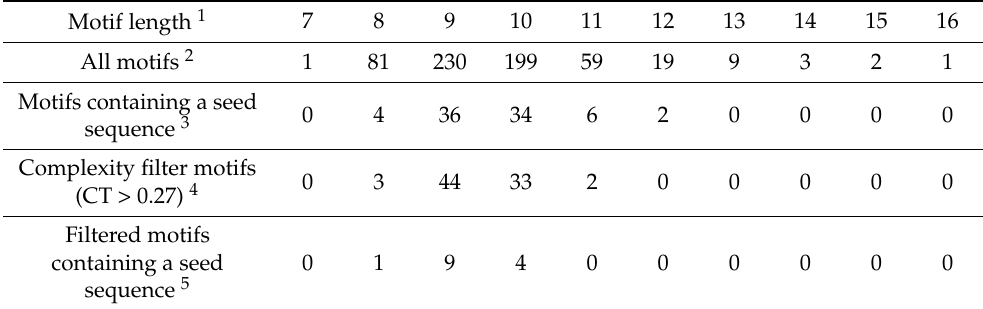
Table 3. Distribution of over-represented sequence motifs with lengths from 7 to 16